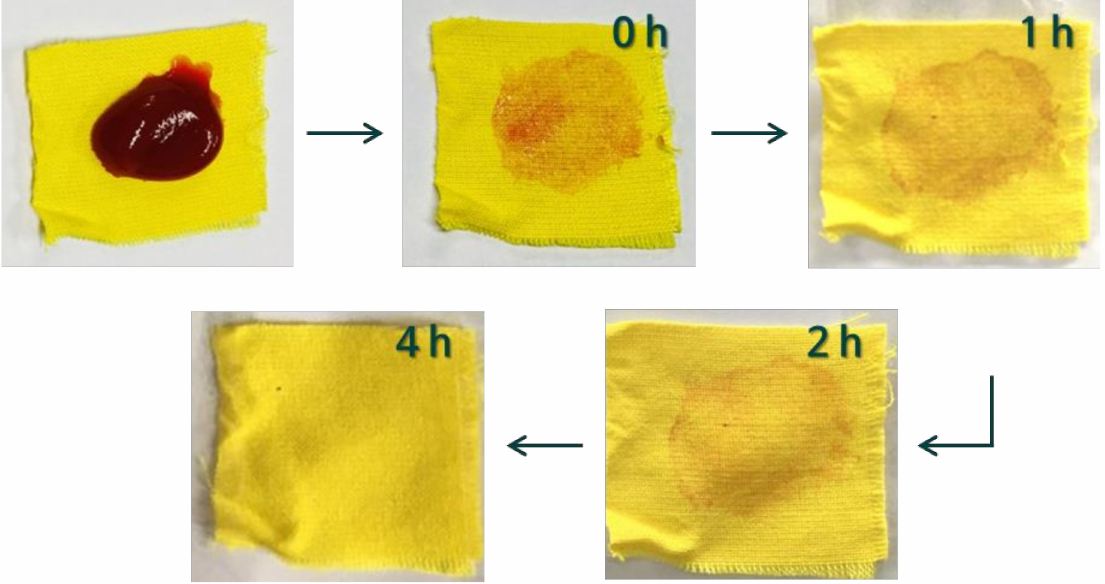
Figure 10. Ketchup stain self-cleaning of the 450TF-H PET